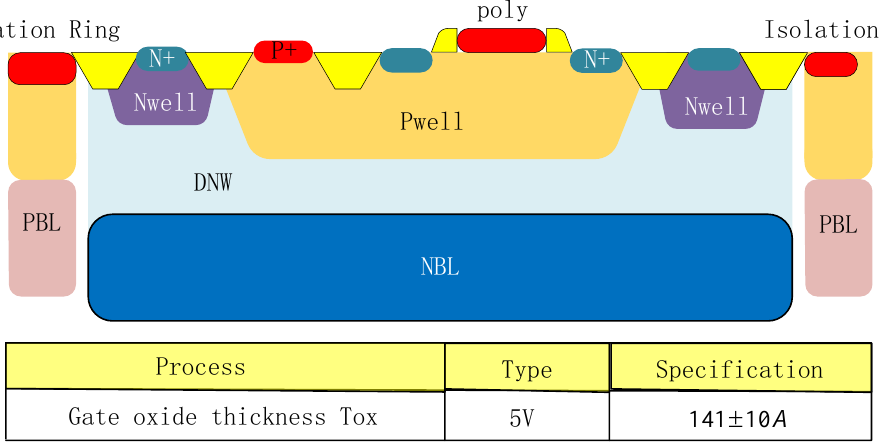
Figure 8. Cross-sectional view of a 5 V type NMOS N-P with deep N-well and